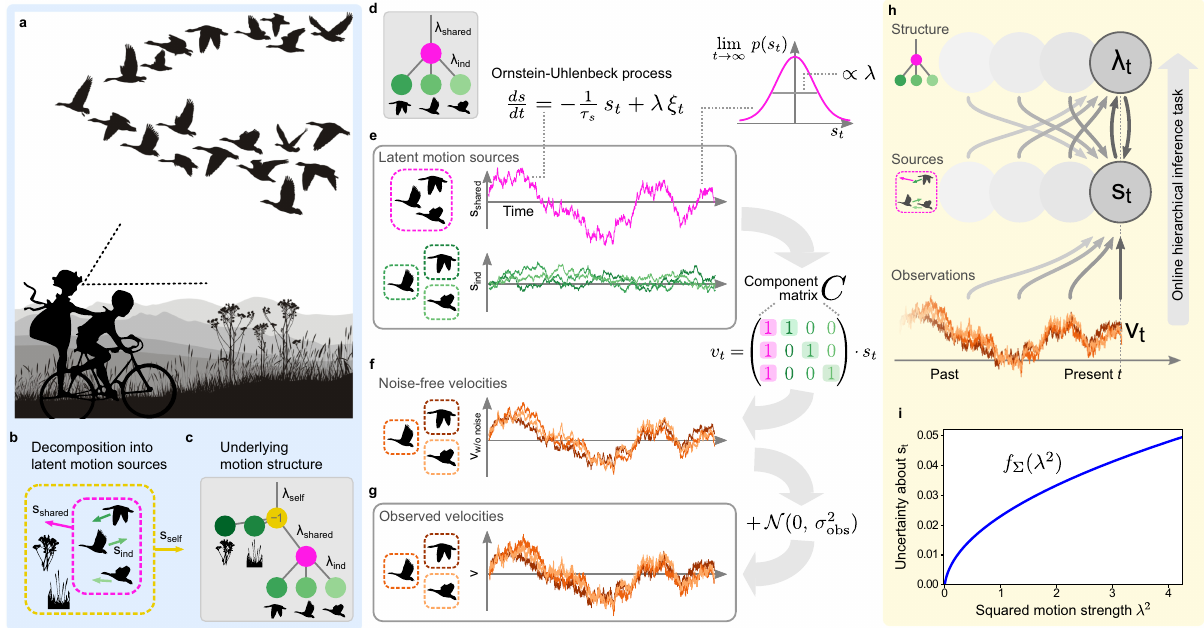
Fig. 1 | Visual motion perception as an online hierarchical inference task. a Scene with nested motion relations. Observed velocities reaching the observer ’ s retina are perceived as a combination of self-motion, fl ock motion and every bird ’ s individualmotionrelativetothe fl ock. b Formaldecompositionofthescene ’ smotion intolatentmotionsources. c Tree-structuredgraphrepresentationoftheunderlying motion structure with nodes corresponding to latent motion sources. Self-motion contributes in the opposite direction to retinal velocity ( − 1). Vertical distances betweennodes,termedmotionstrengths, λ ,describethelong-termaveragespeedof the source. Vanishing motion strength indicates that the corresponding motion sourceisnotpresentthescene. d – g Generativemodelofstructuredmotion. d Graph for a simpler motion scene with three fl ocking birds and a stationary